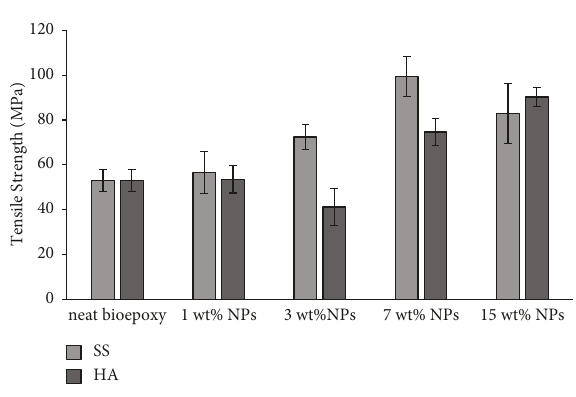
Figure 4: Impact of the incorporation of different mass fractions of HA or SS nanoparticles on the tensile strength of bioepoxy.